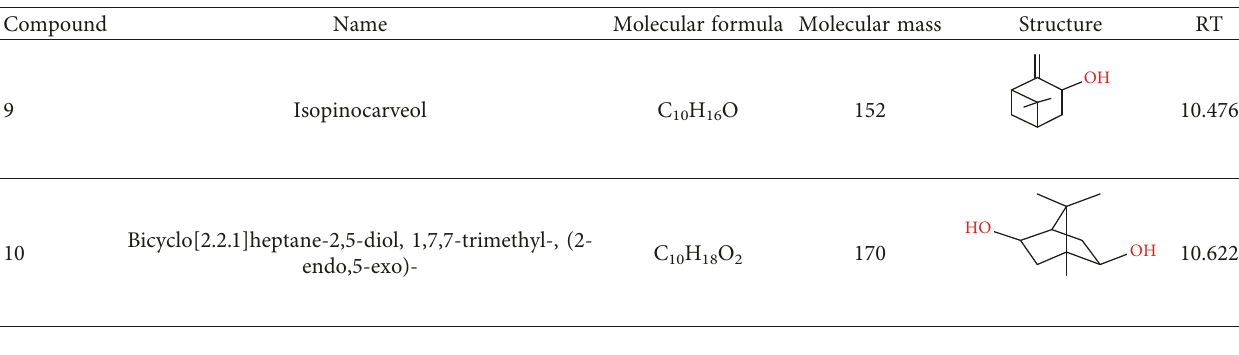
Table 4: Molecular formula, molecular mass, structure, and RTof compounds 11–15 of whole plant n -hexane fraction of Achillea wilhelmsii (WHFAW).